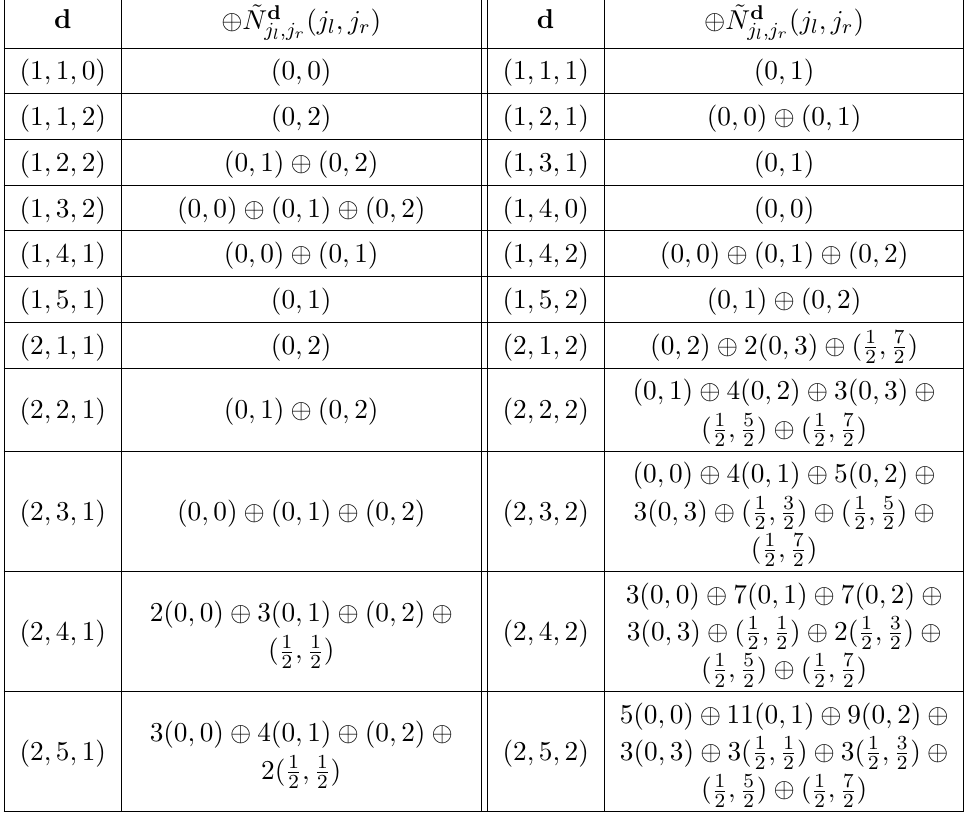
Table 21 . Spectrum of the anti-fundamental Wilson loop operator in the SU(3) 9 theory for ( d 1 , d 2 , d 3 ) ≤ (2 , 5 , 2) . Here, d = ( d 1 , d 2 , d 3 ) labels the BPS states with fugacity Q − 2 / 3